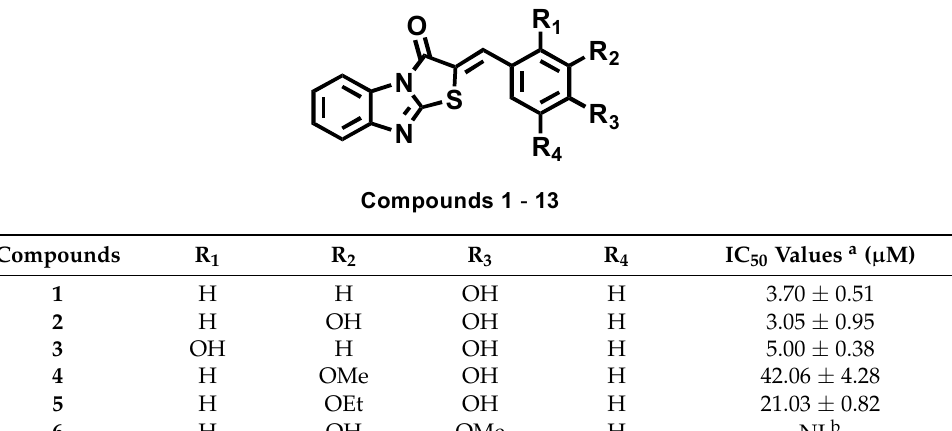
Table 2. Mushroom tyrosinase inhibitory activity of ( Z )-2-(substituted benzylidene) benzimidazothiazolone derivatives 1 – 13 .